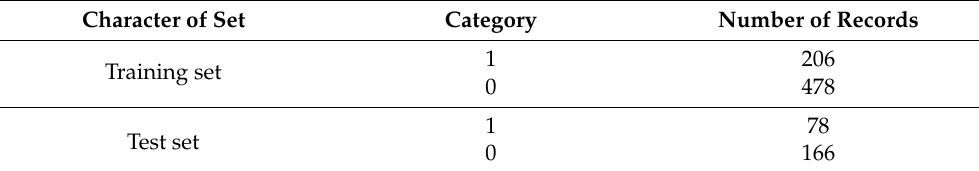
Table 12. Number of records by set type and category of dependent variable after stratification.